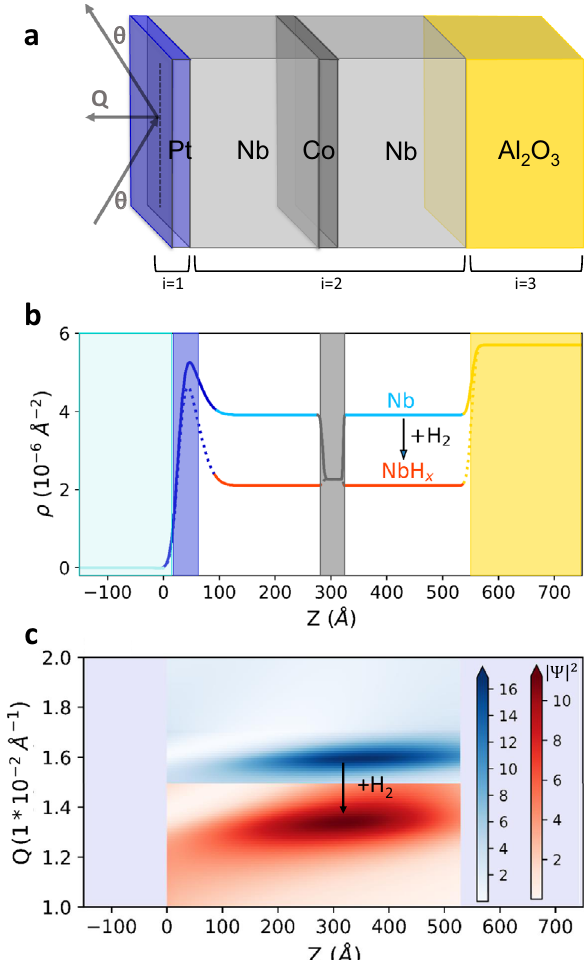
Fig. 1 Resonant neutron re fl ectometry scheme. a Sketch of the thin- fi lm structure and geometry of the re fl ectometric measurements. Q is the wavevector transfer, and θ the scattering angle. b Depth pro fi le of the scattering length density ρ of the sample before (blue line) and after (red line) incorporation of 85 at.-% hydrogen. c The numerically calculated neutron density enhancement (with respect to the incoming beam with Ψ j j 2 ¼ 1), along the fi lm before (blue) and after (red) hydrogenation. For simplicity, the schematic does not include the H-induced swelling of the fi